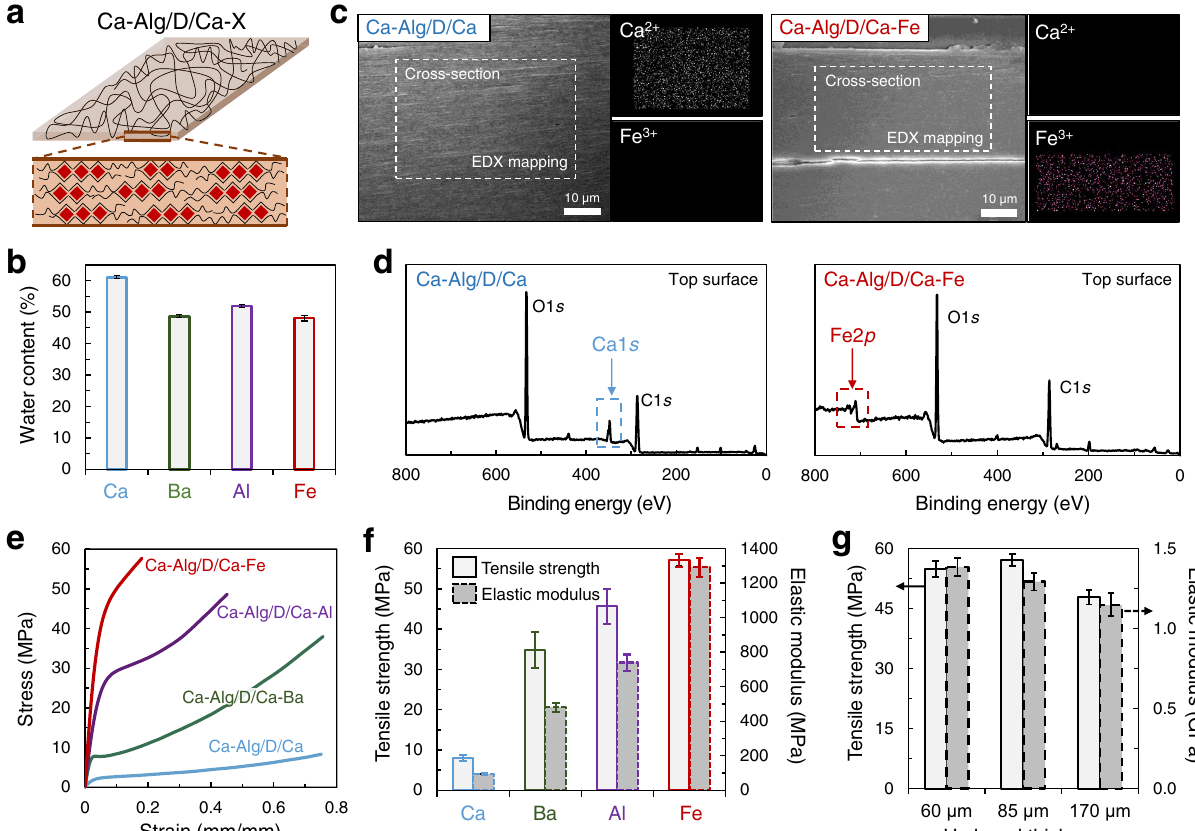
Fig. 3 Enhanced mechanical properties of the reconstructed hydrogels crosslinked by various cations. a Illustration of secondary-ion-crosslinked Ca – Alg/D/Ca – X hydrogels through the exchange from Ca 2 + ions with other cations by soaking in BaCl 2 , AlCl 3 , or FeCl 3 solution. b Water content in the resulting hydrogels. c Energy-dispersive X-ray spectroscopy (EDX) mapping of the cross-section and d X-ray photoelectron spectroscopy (XPS) pro fi les of the upper surface of Ca – Alg/D/Ca and Ca – Alg/D/Ca – Fe. e Stress-strain curves and f tensile strengths and elastic moduli of the reconstructed hydrogels. g Tensile strengths and elastic moduli of Ca – Alg/D/Ca – Fe with different thicknesses. Error bars correspond to standard deviations. NATURE COMMUNICATIONS| (2022) 13:3019